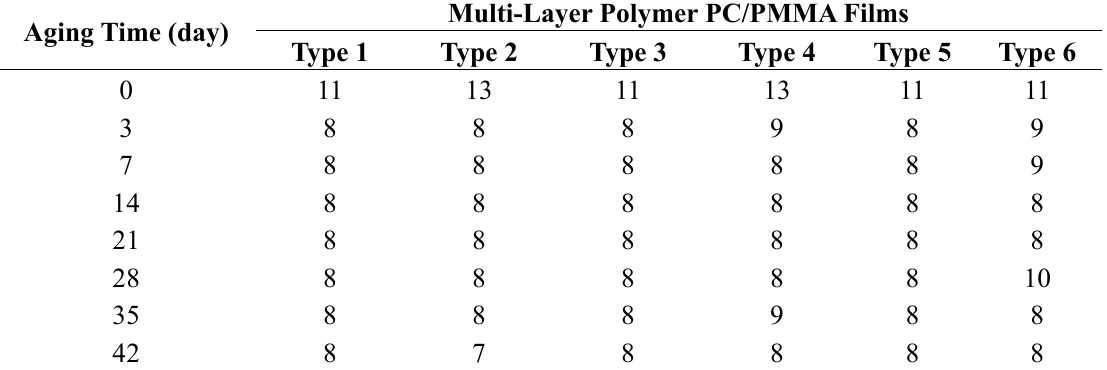
Table 3. Test matrix showing sample numbers at each aging time for testing for each sample type at 100 °C aging